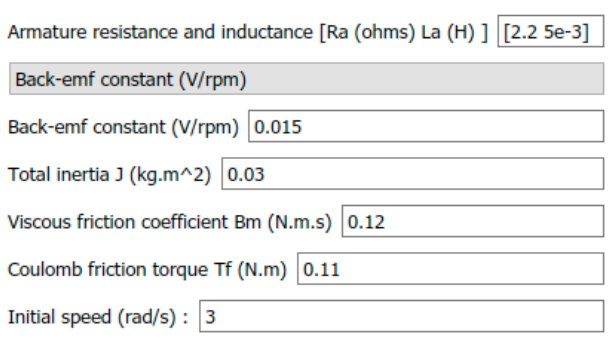
Figure 8. MPPT Control Schematic. Table 3. Table containing the parameters of the DC motor.